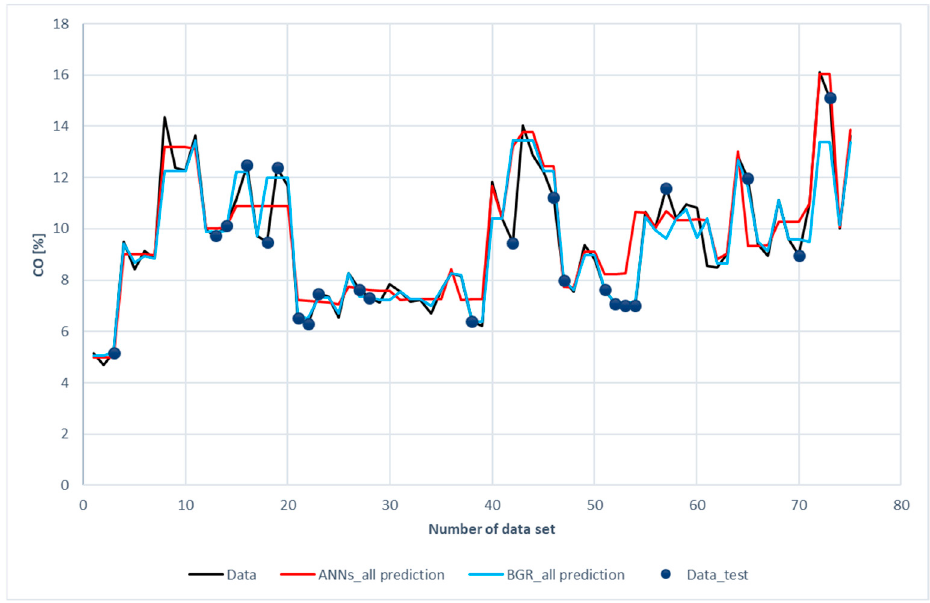
Figure 10. Comparison of CO compositions among the experimental data with the ANN and GBR models.